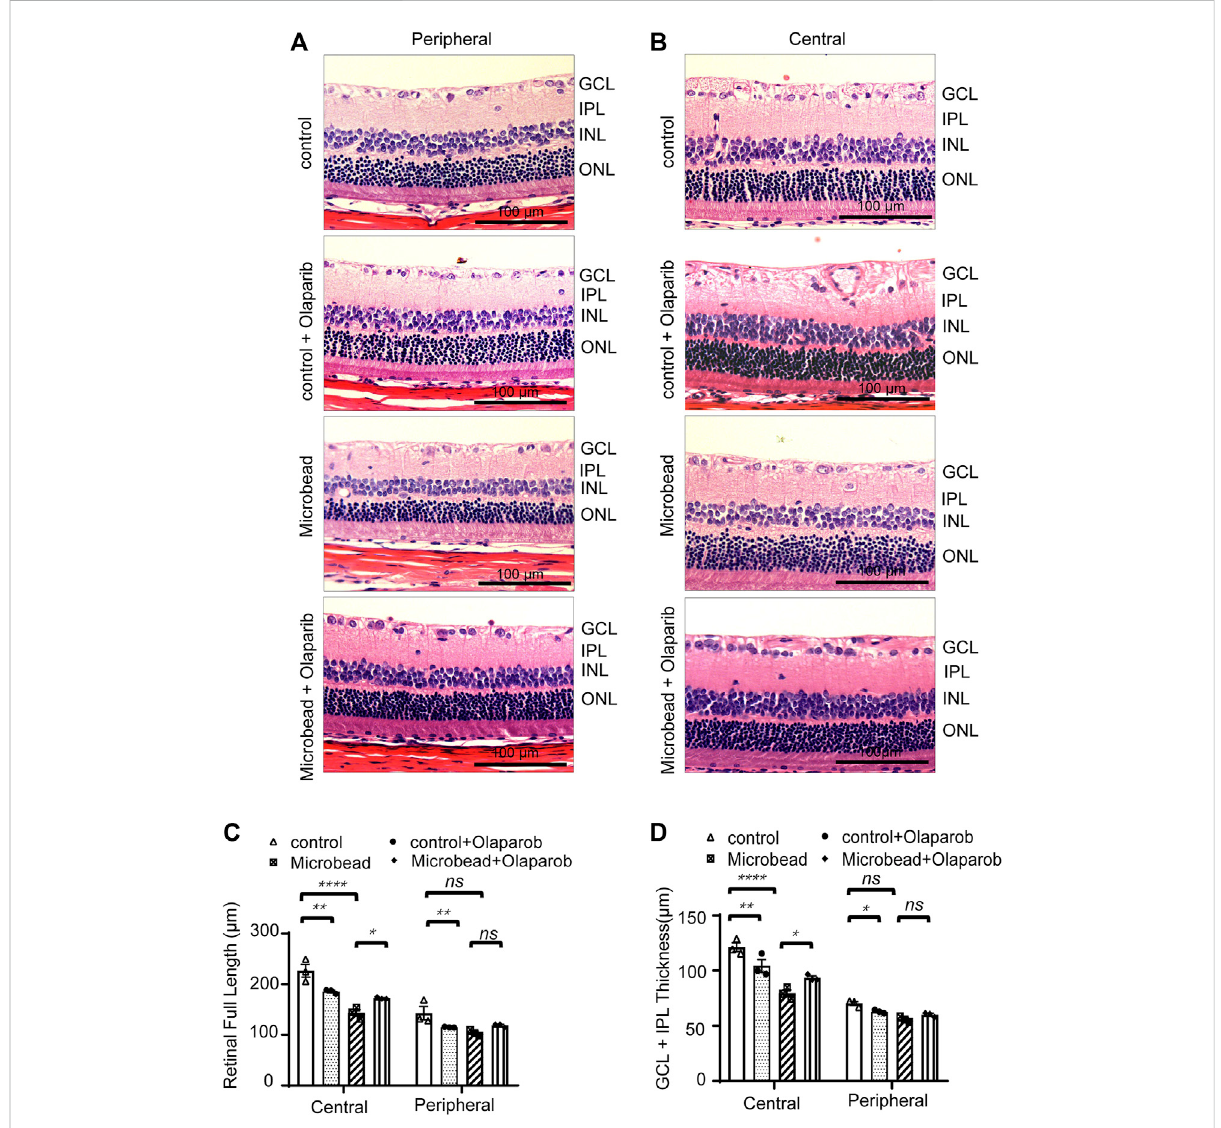
FIGURE 5 Olaparib relieves chronic ocular hypertension-induced retinal damage as re fl ected bychanges inretinal thickness. H&E staining ofretinal slices in the central area (A) and peripheral area (B) (magni fi cation ×20, scale bar, 100 μ m). (C – D) Quantitative analysis of retinal (full length) thickness and GCL+IPLretinalthickness.Dataarepresentedasthemeans±SEM(n=3ratspergroup).The p -valuesweredeterminedusingone-wayANOVAwith Tukey ’ s test for multiple comparisons. p p < 0.05, pp p < 0.01, and pppp p <